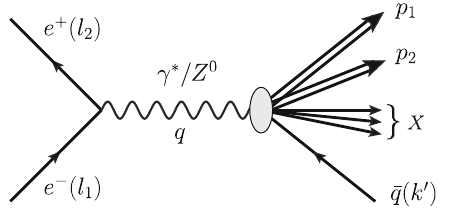
Fig. 1 Illustratingdiagram for the e + + e − → h 1 + h 2 + ¯ q + X process